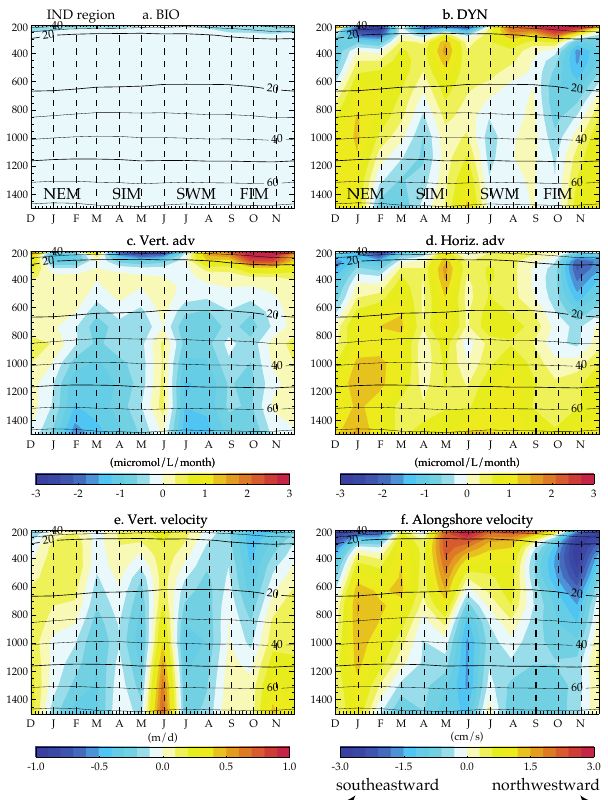
Fig. 8. Seasonality in IND region (see Fig 1 j) between 200 and 1500m in the model. (a–d) Components of the oxygen budget (µmolL − 1 month − 1 ) with the biological trend (a) , the dynamical transport (b) , and the contributions of ver- tical advection ( (c) and horizontal advection (d) to the dynamical transport (e) vertical velocity (md − 1 ). (f) Alongshore component of horizontal velocity (cms − 1 ), where values > 0 ( < 0) indicate north- westward (southeast ward) velocities. Contours indicate the oxygen concentration in the region (µmolL − 1